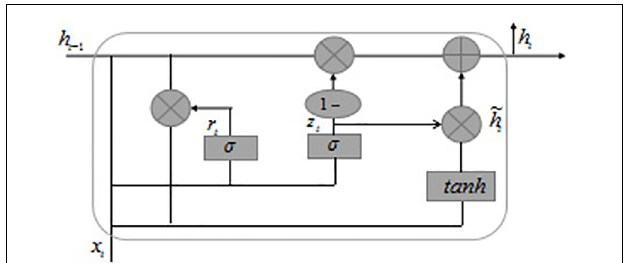
FIGURE 3 | GRU model structure.